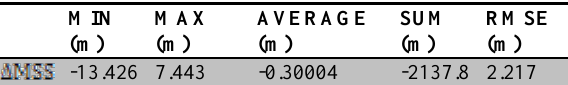
Table 3. Statistic of the difference between DTU13 Global MSS Model and Localised MSS Model